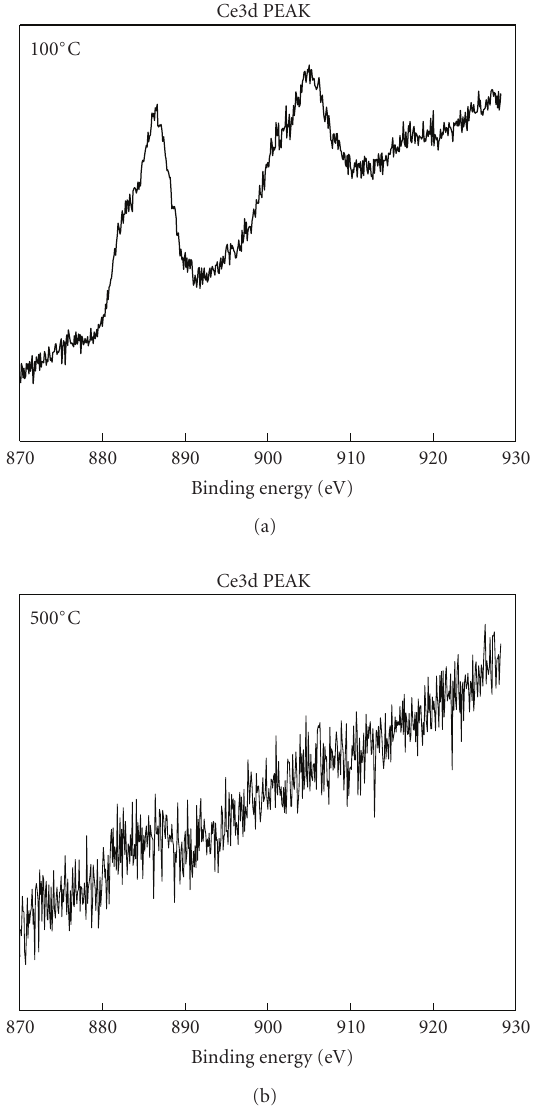
Figure 5: Complete disappearance of the cerium signal on the Ce- treated A361 surface.